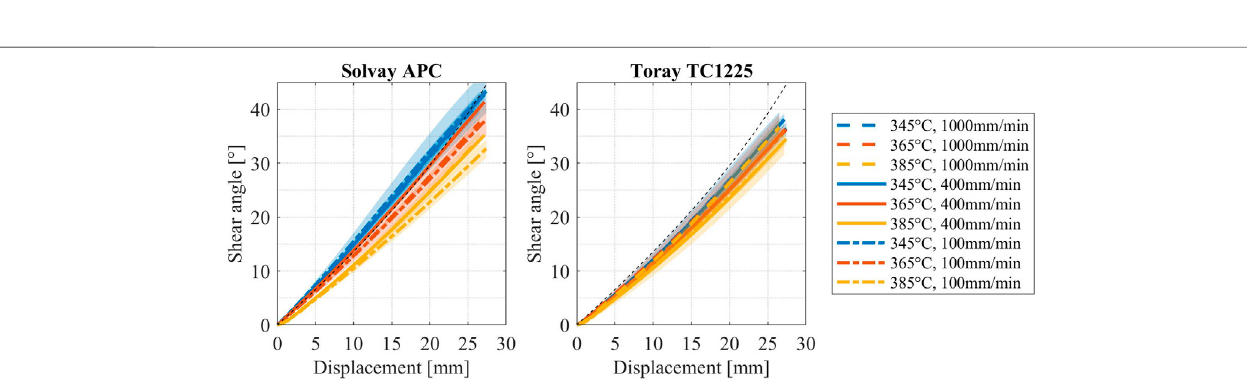
Frontiers in Materials |